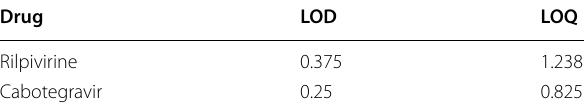
Table 3 Results of linearity Table 4 Results of LOD AND